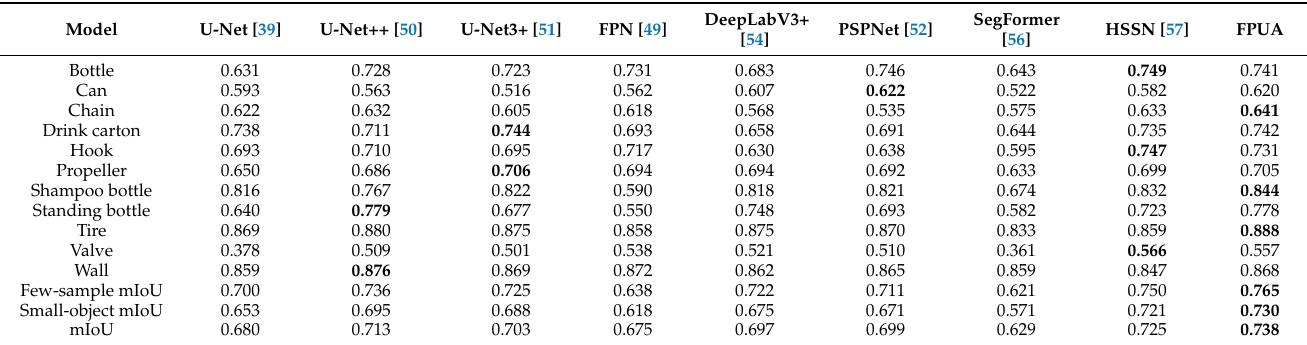
Table 3. IoU for each class in the test set for investigation of segmentation model performance. The best segmentation accuracy for each class is marked